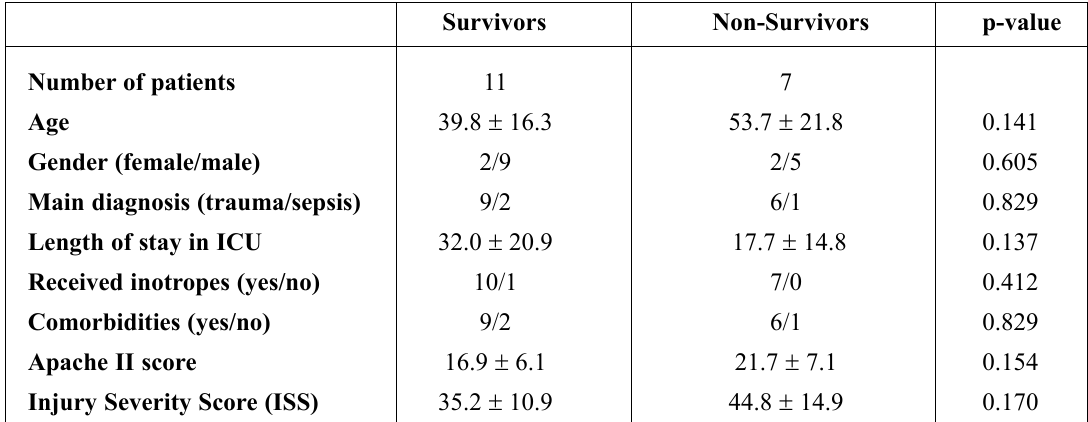
Table 1. Characteristics of all patients, survivors versus non-survivors. Data are presented as mean values SD if not stated otherwise (n.s. = not